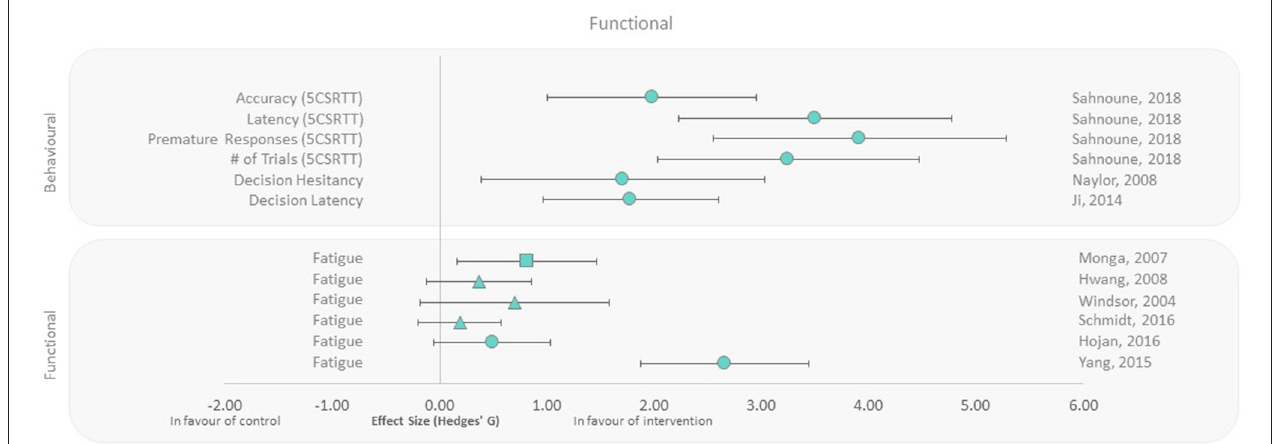
FIGURE 5 | Effect size plot of behavior in animals and fatigue in human trials. Outcomes are plotted with the Hedges’ g calculated for each outcome extracted and bias corrected for sample size. Confidence intervals of 95% are represented by the error bars. Effect size values that are in the positive rightward direction indicate a beneficial effect in favor of the exercise intervention group compared to the non-exercise control group. Shapes refer to the time at which the exercise intervention was applied with respect to the radiation exposure (Post—Circle, Pre—Square,